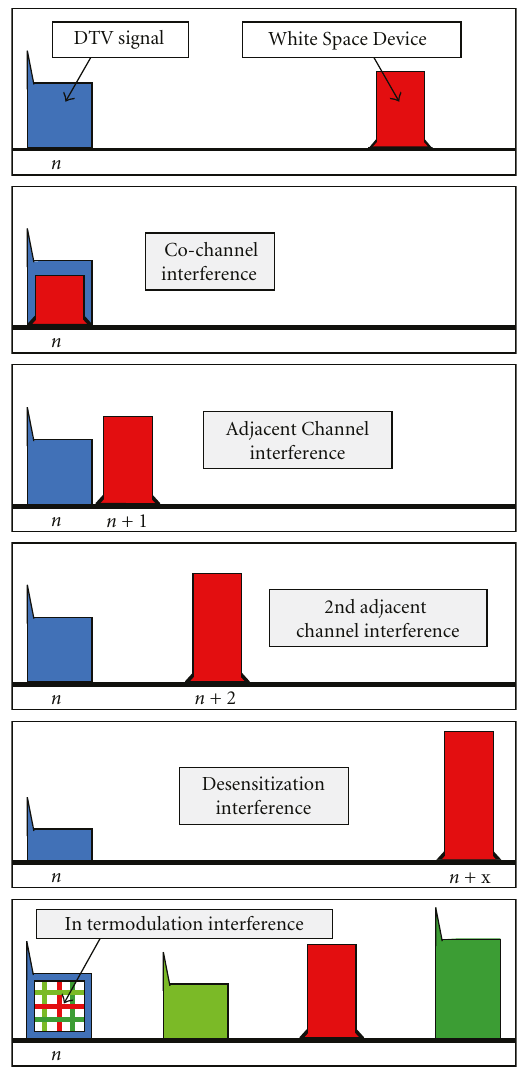
Figure 3: Types of potential WSD interference to DTV signals.